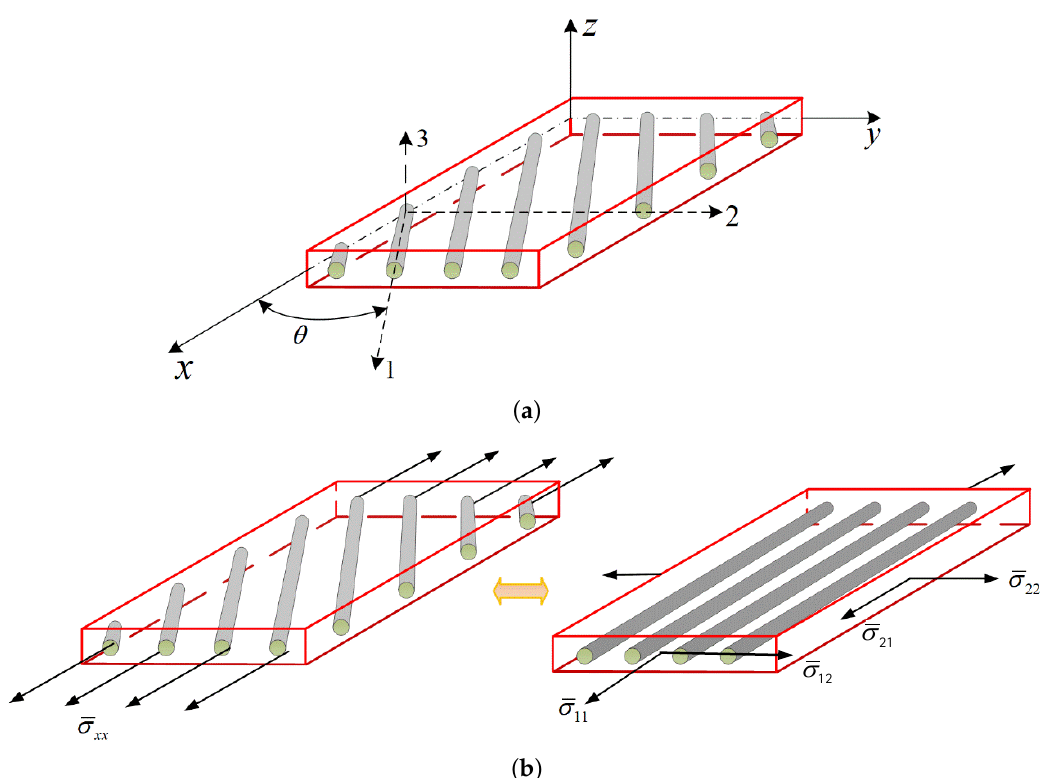
Figure 10. The relation between the principal coordinates and global